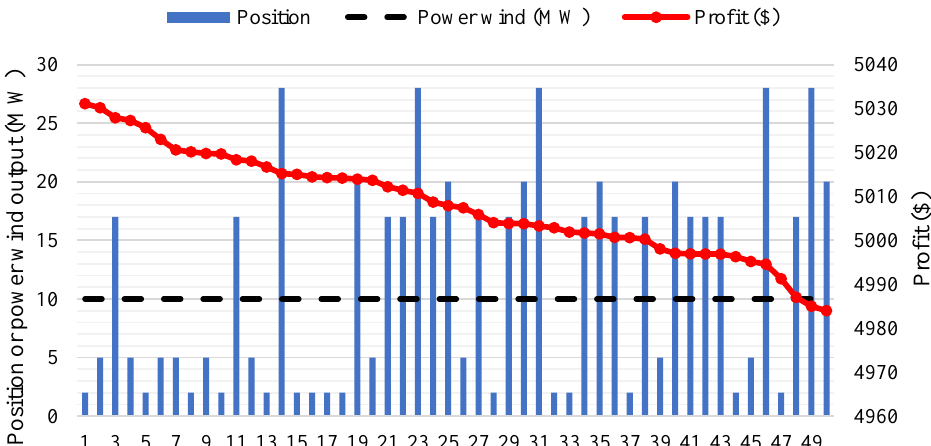
Figure 13. Optimal location and size of wind turbine obtained by WCA for 50 runs.